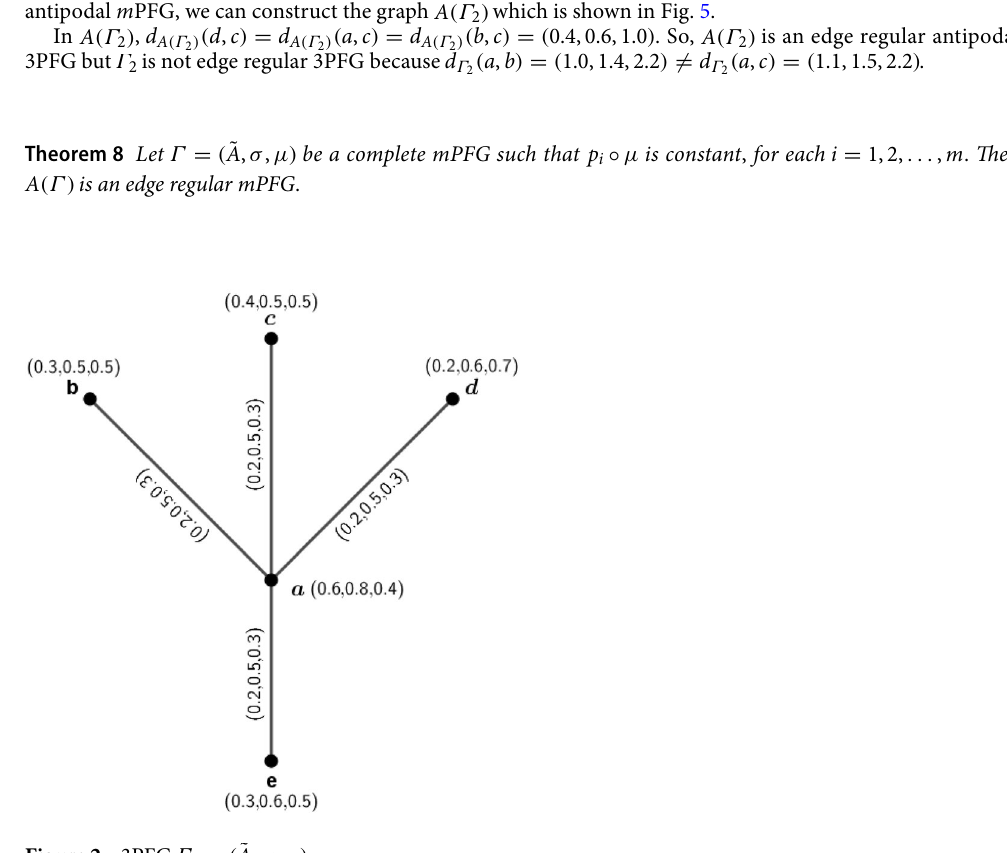
Figure 2. 3PFG Γ 1 = (